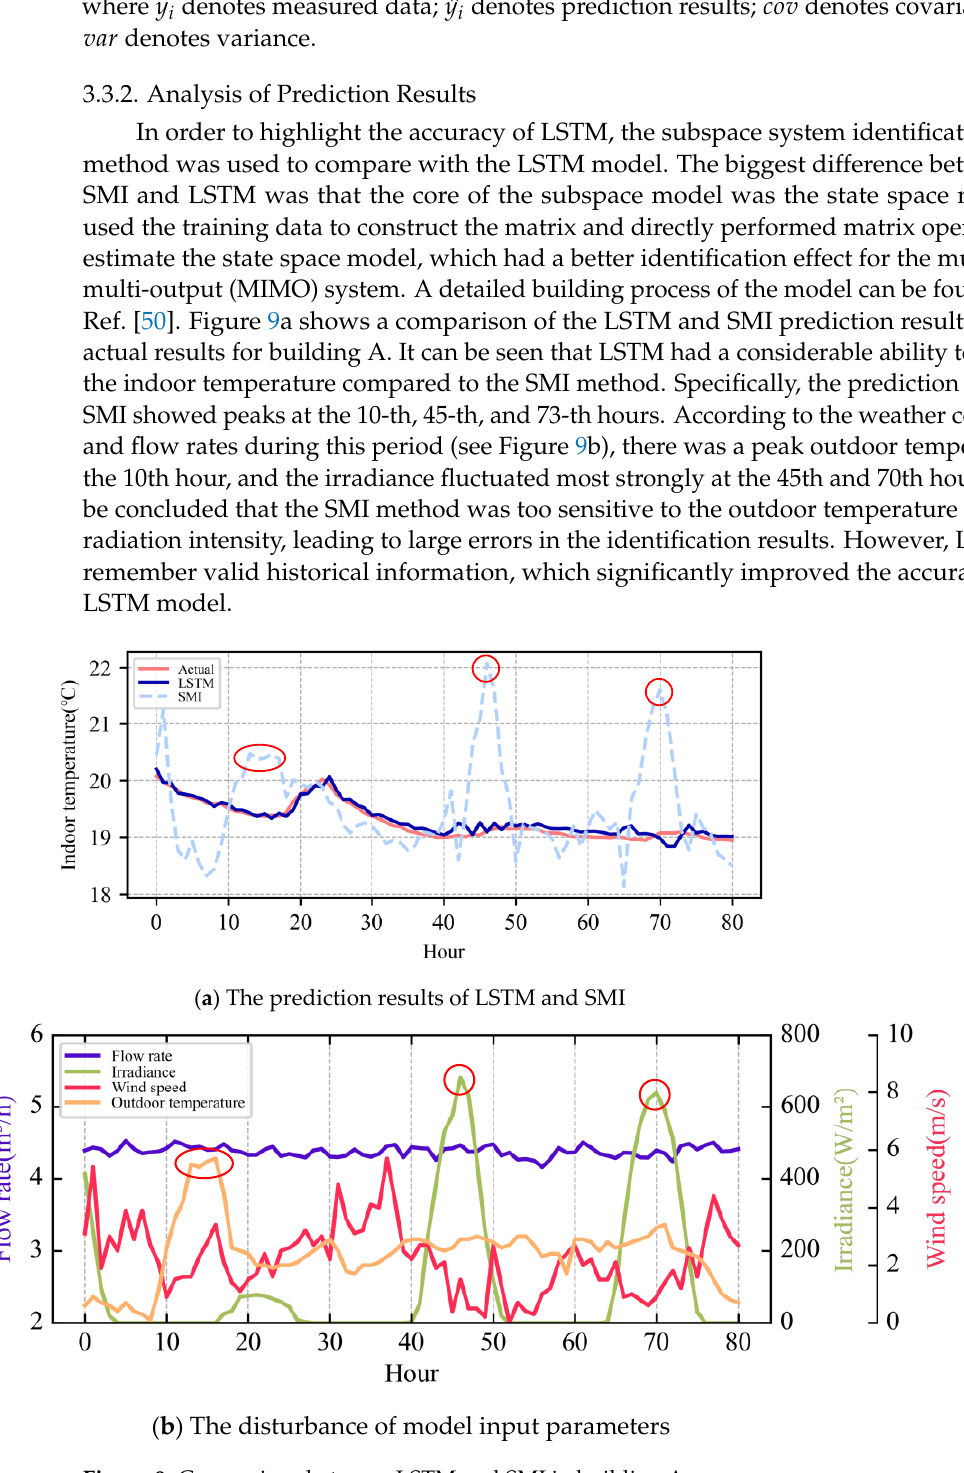
( b ) Building C Figure 10. The prediction results of LSTM in building B and building C. Table 4. Evaluation metric results of LSTM in three buildings. Building